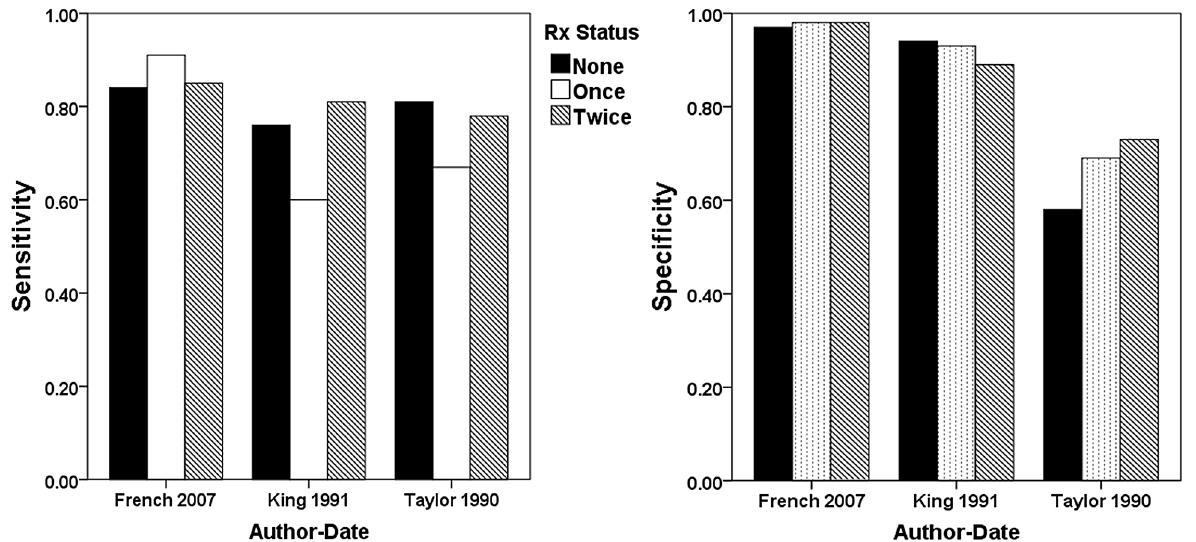
Figure 6. Dipstick performance before treatment and after one or two rounds of therapy. Shown are the dipstick diagnostic characteristics in the three studies that provided data on performance after multiple rounds of school age chemotherapy. Sensitivity, as described for the individual studies [9,29,30], is shown in the left panel and specificity in the right panel, with treatment status indicated as follows: solid black bars, untreated children; open bars, children previously treated one time; hatched bars, children previously treated twice.